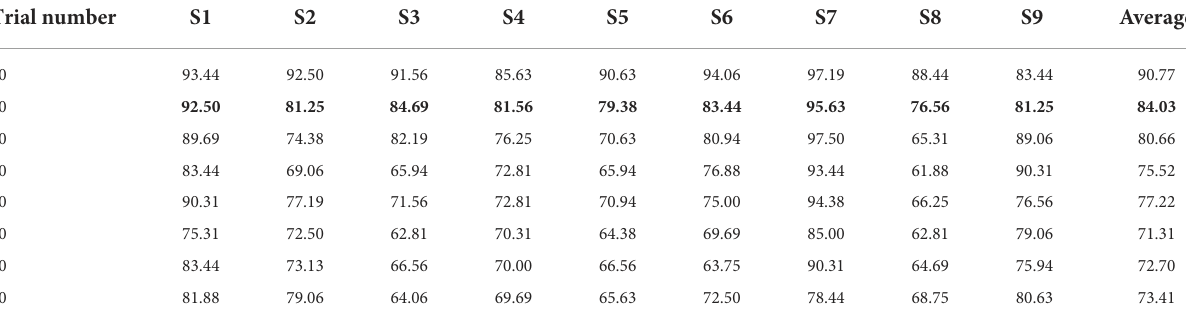
TABLE 5 The accuracy ( % ) for applying different trial numbers to calculate the multi-channels clustered feature in griping vs. opening